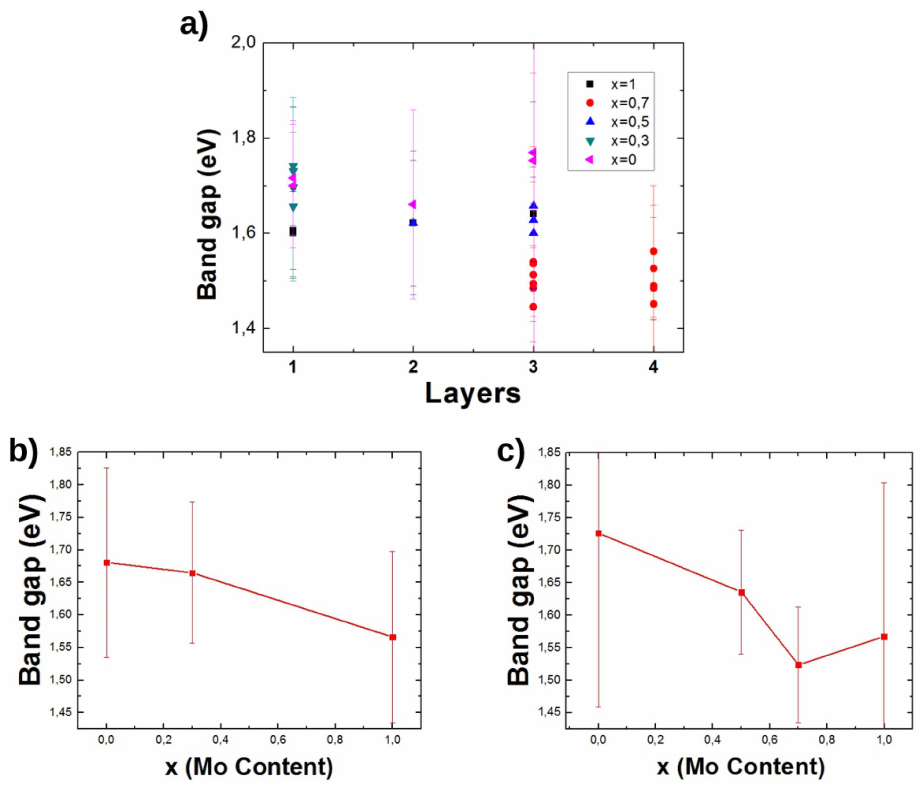
Figure A4. Additional results concerning the alloy band gap. ( a ) Raw values for the band gap measurements in these studies. Error bars are taken as the error in the onset of their corresponding linear regression. ( b ) Average results for alloy monolayers. ( c ) Average results for alloy